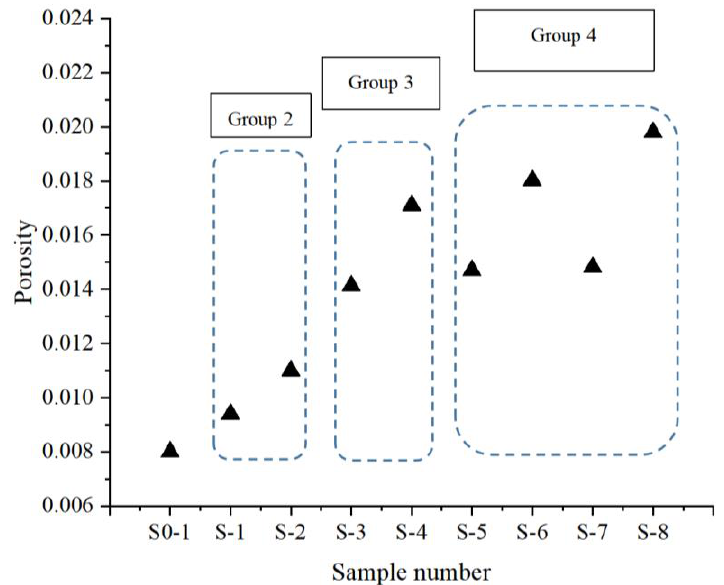
Figure 6. Porosity variation of granite under the action of different stimulation. Comparing samples S0-1, S-3, S-5 and S-7, the porosities are 0.0081, 0.0142, 0.0147 and 0.0149, respectively. It can be seen that when the reaction time is 7 days, the porosity of granite increases significantly, and the effect of thermal-CO 2 superposition stimulation is more